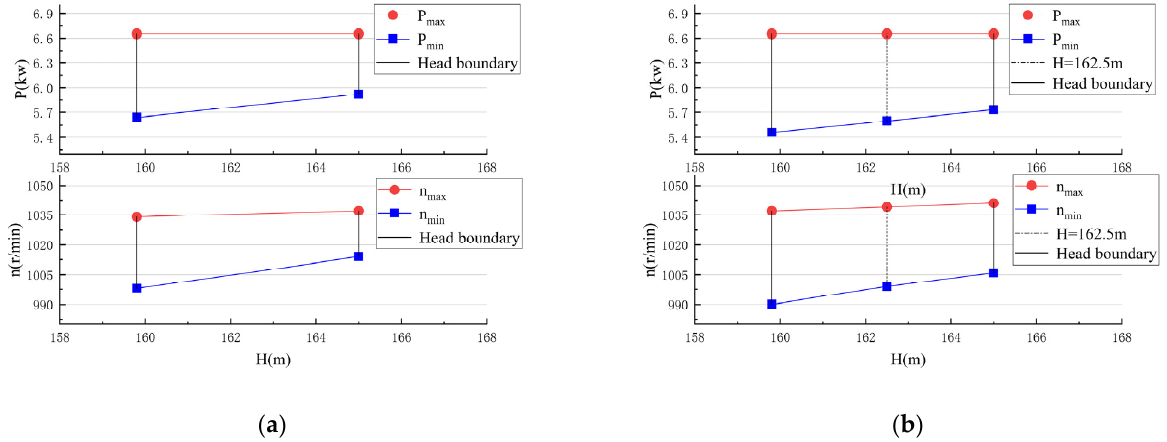
Figure 19. Relation graph of speed and input power variation: ( a ) opening at 52.6%; ( b ) opening at 63.2%.